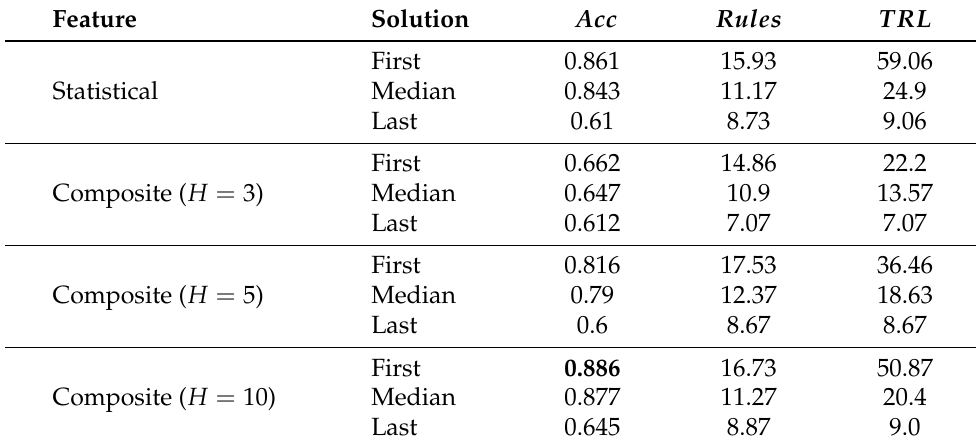
Table 14. Performance achieved by the proposed classifier over the UPC data